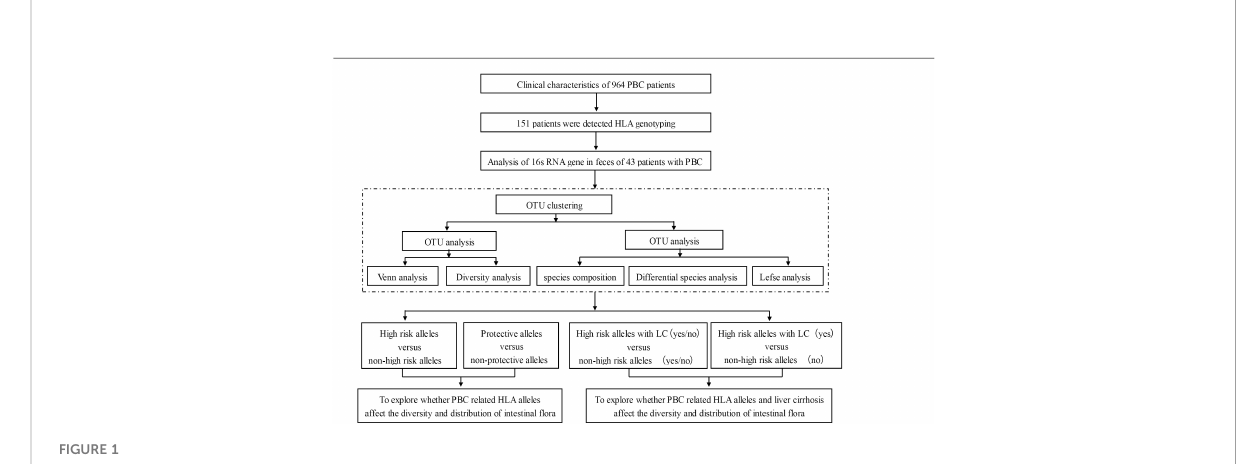
FIGURE 1 The study fl